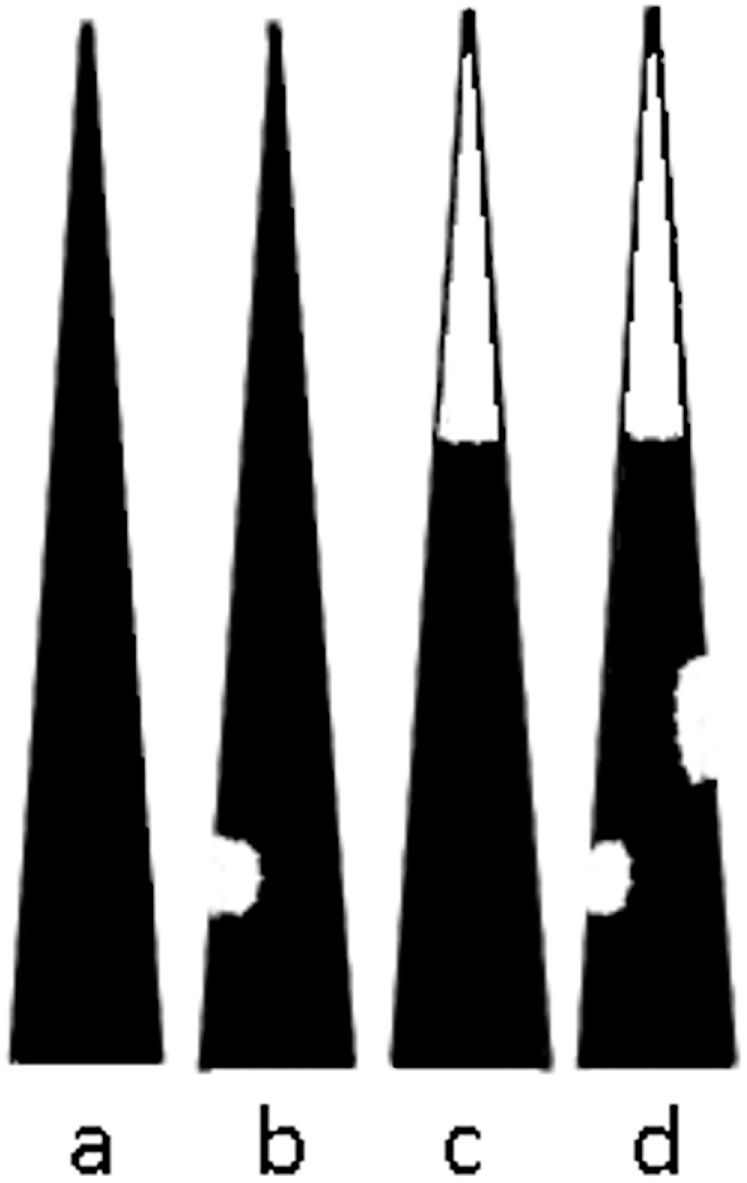
Fig 2. Four possible situations encountered for S . alterniflora leaves: a) leaf tip intact, no grazing (76.1% of leaves), b) leaf tip intact, grazed (6.4% of leaves), c) leaf tip missing, no grazing on remaining portion (3.2% of leaves), d) leaf tip missing, grazed on remaining portion (14.2% of